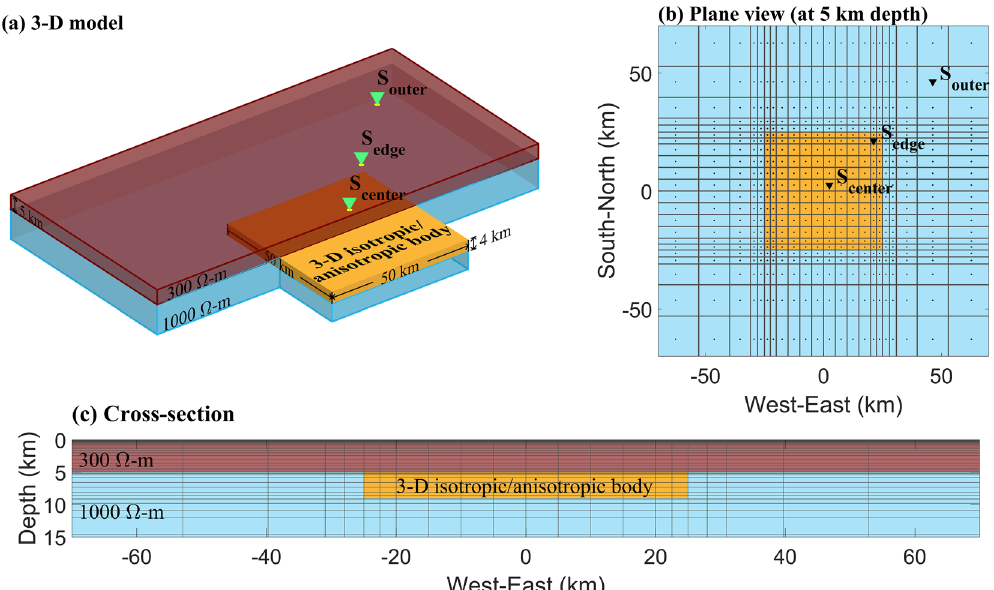
Fig. 1 a Three‑dimensional isotropic/anisotropic model adapted from the 2‑D model of Pek et al. (2008) for the case where the 3‑D body is buried at a depth of 5 km. b Plane view at a depth of 5 km. c Cross‑section along west–east direction ( y ‑axis). The two isotropic 300 Ω‑m and 1000 Ω‑m layers are kept fixed. Only the 3‑D body will be changed to either anisotropic or isotropic resistivity with various resistivity values. The 3‑D body was buried at various depths: 0 km (surface), 5 km (shown above), and 20 km. Dots at the surface on b are the 484 MT stations used in this study. S center , S edge , and S outer are the stations discussed in the next